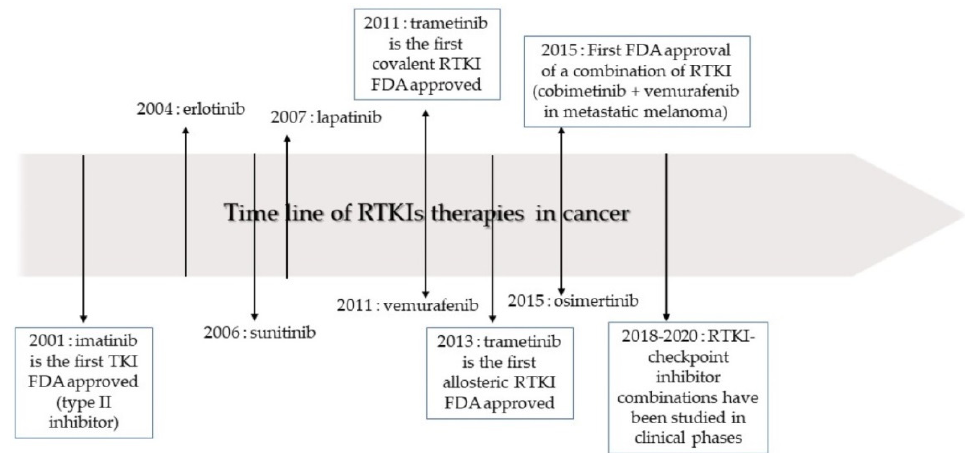
Figure 2. The timeline of receptor tyrosine kinase inhibitor (RTKI) development and approval for the treatment of cancer. Adapted from [31], Copyright 2020 MDPI.